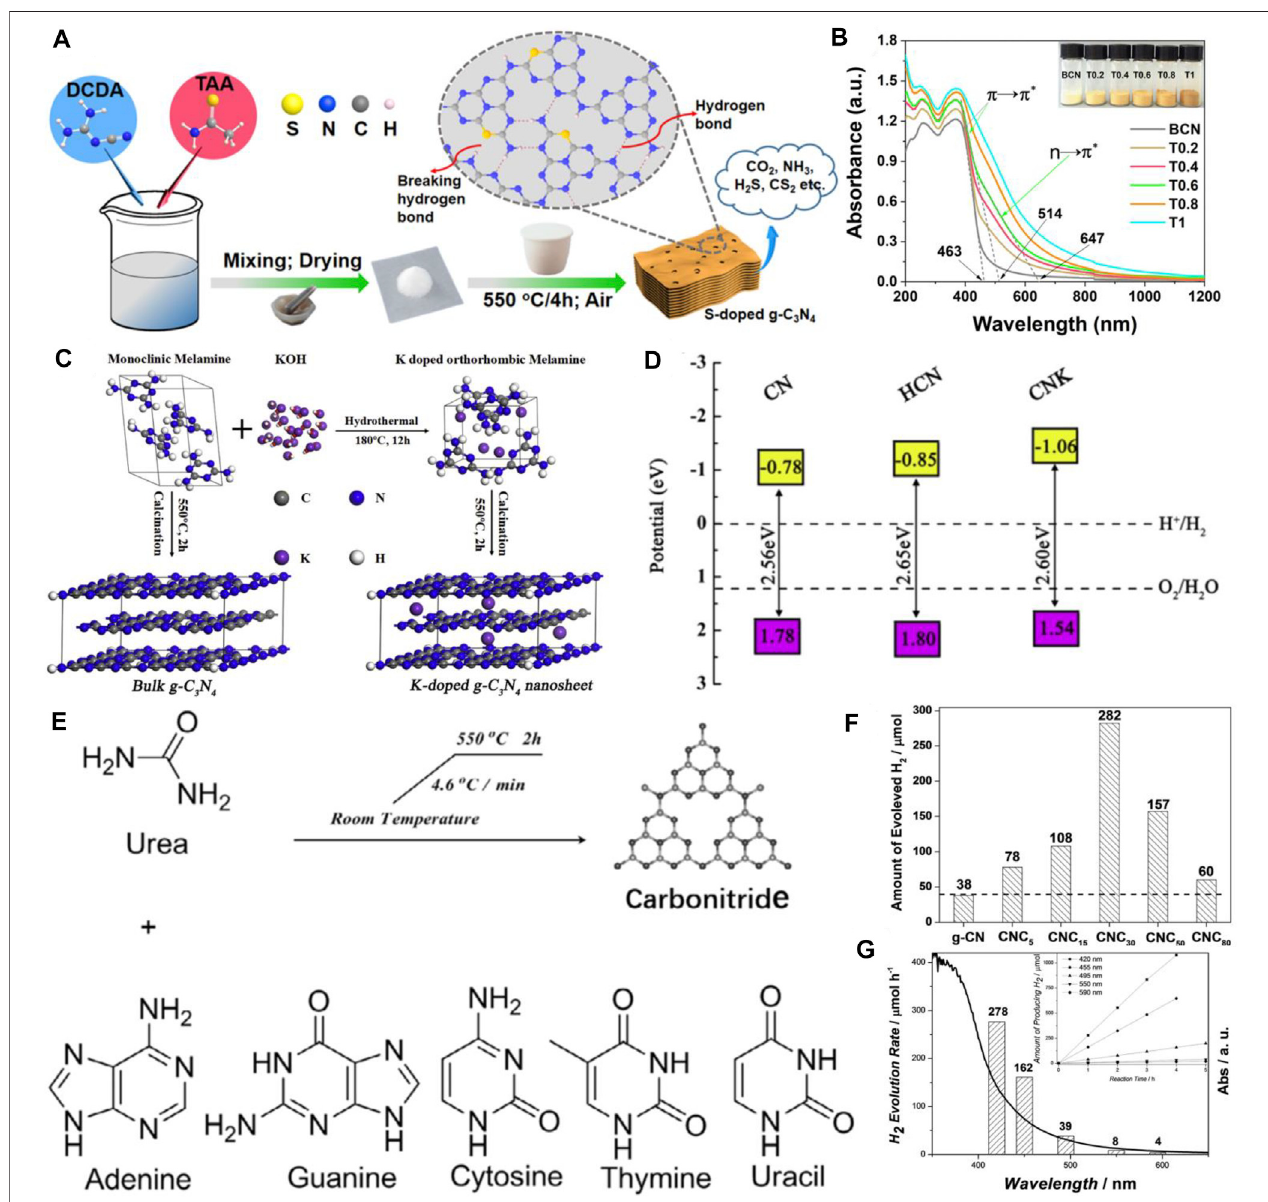
FIGURE 2 | (A) Schematic illustration for the formation of multi-layered cake-like porous g-C 3 N 4 with broken hydrogen bonds by S-doping, (B) UV – visible diffuse re fl ectance spectra of samples. Copyright 2020, Elsevier; (C) Schematic illustration of the KOH-assisted hydrothermal-reformed melamine strategy for achieving simultaneous K-doping and exfoliation of g-C 3 N 4 , (D) band structure alignments for the CN, HCN, and CNK sample. Copyright 2018, Elsevier; (E) Chemical production of polymeric carbon nitride semiconductors from nucleobases and urea, (F) Effect of cytosine amount on the HER, (G) wavelength dependence of the HER with CNC 30 loaded with 3 wt% Pt. Inset: time-dependence of the HER with CNC 30 at different irradiation wavelengths. Copyright 2017 John Wiley and Sons, Inc.